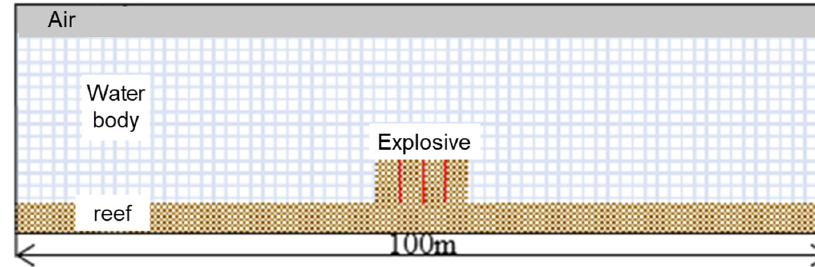
Figure 4. Schematic diagram of the model.